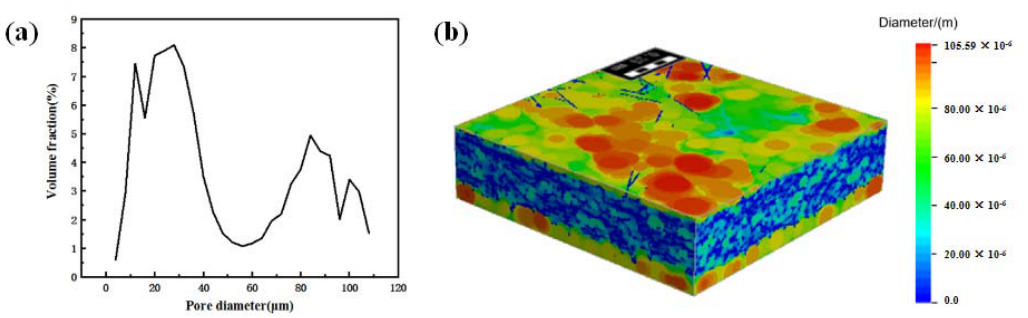
Figure 5. Pore size distribution of MnO 2 /MWCNTs composite electrode: ( a ) 2D pore size distribution; ( b ) 3D pore size distribution.